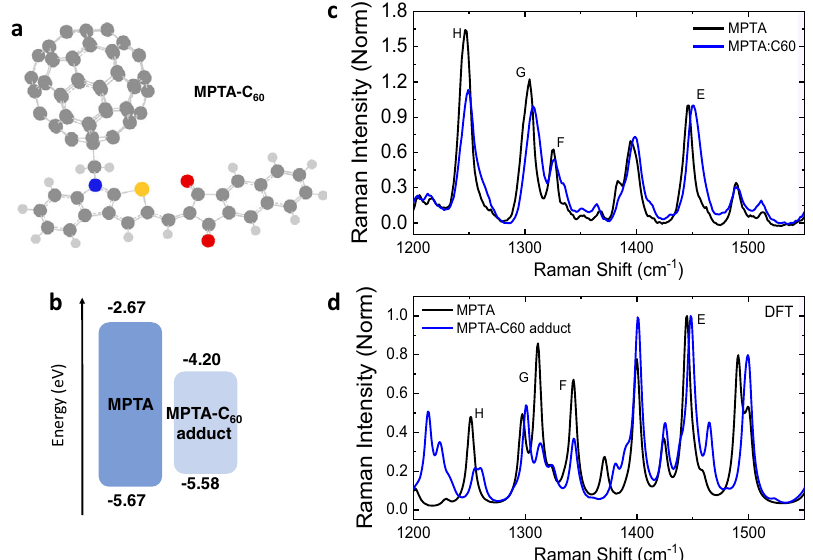
Fig. 4 MPTA-C 60 adduct. a Chemical structure of MPTA-C 60 adduct, in DFT optimized structure. b Calculated energy levels for MPTA and MPTA-C 60 adduct. c Measured Raman spectra of neat and blended MPTA, normalized to peak E from the core thiophene. d DFT simulated Raman spectra for MPTA and MPTA-C 60 adduct.